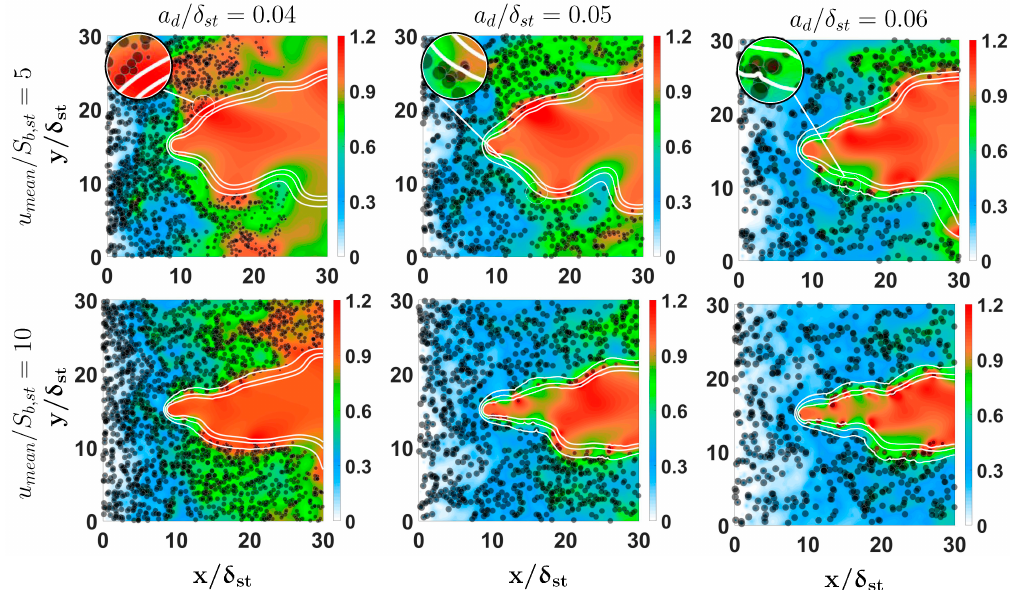
Figure 1. Instantaneous fields of gaseous equivalence ratio, φ g on the central x-y midplane for initial a d / δ st = 0.04, 0.05, 0.06 with u mean / S b , st = 5.0 (1st row) and 10 (2nd row) at t = 2.0 t flow . White lines illustrate c = 0.1, 0.5 and 0.9 contours from outer to inner periphery and the droplets residing on the plane are indicated by grey dots (not to the scale).